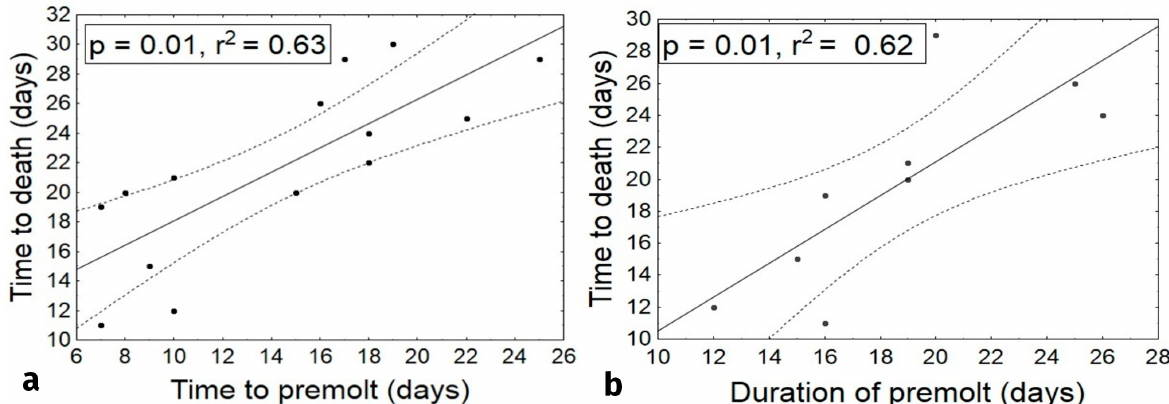
Figure 3. Relation between death and the premolt (a) and the duration of the premolt stage (b), the 95% confidence interval for Callinectes ornatus subjected to different experimental treatments for 30